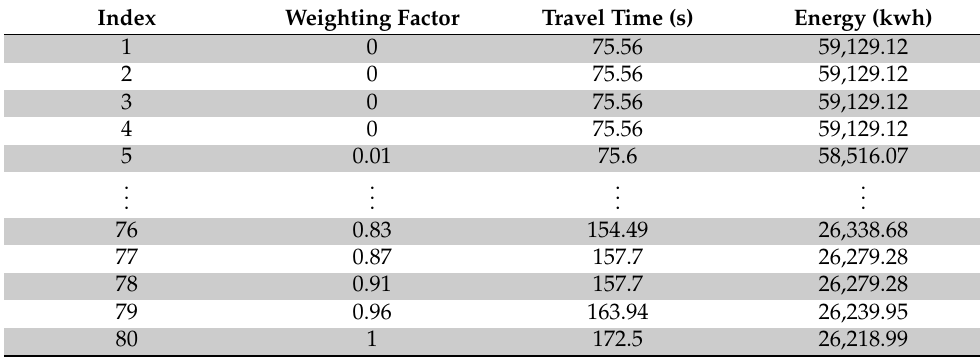
Table 5. Results of speed profiles obtained for multiple